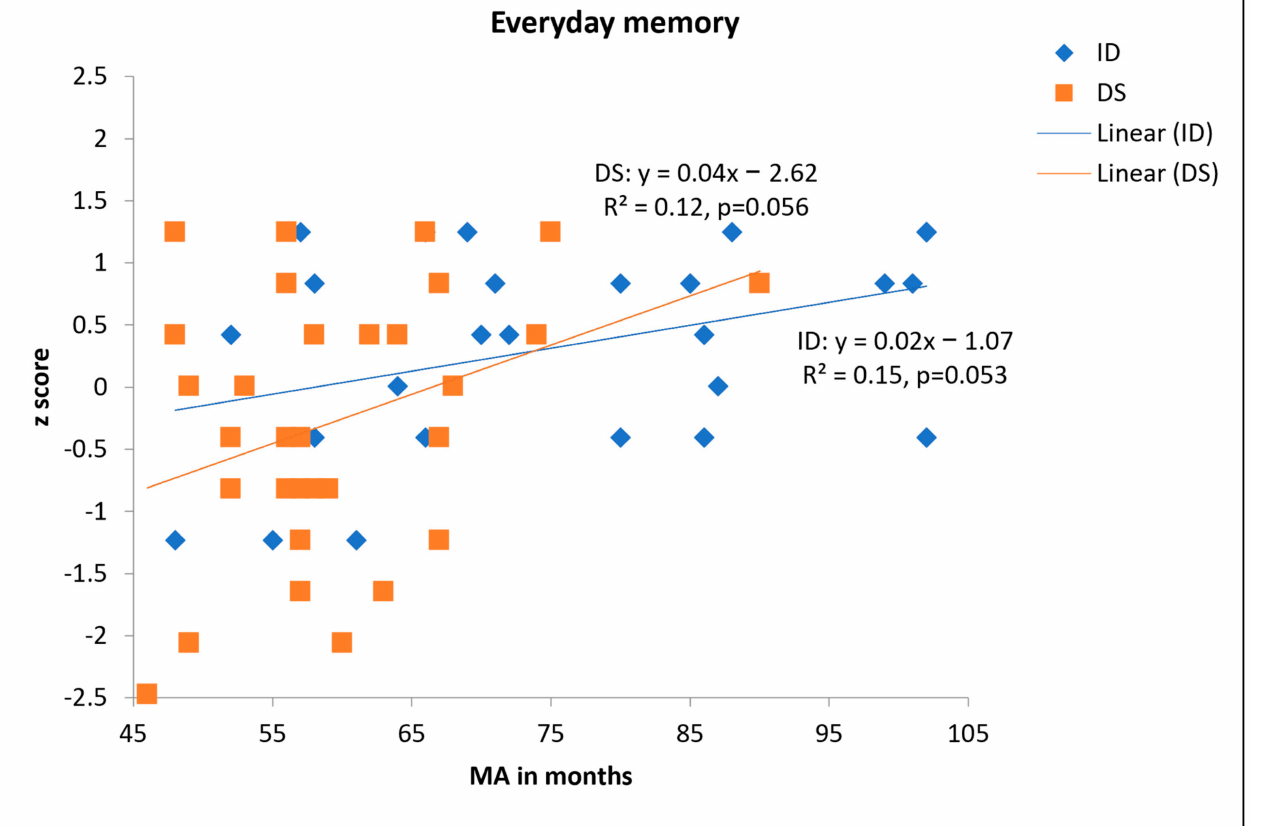
Figure 1. Scatterplot of z scores in everyday memory as a function of